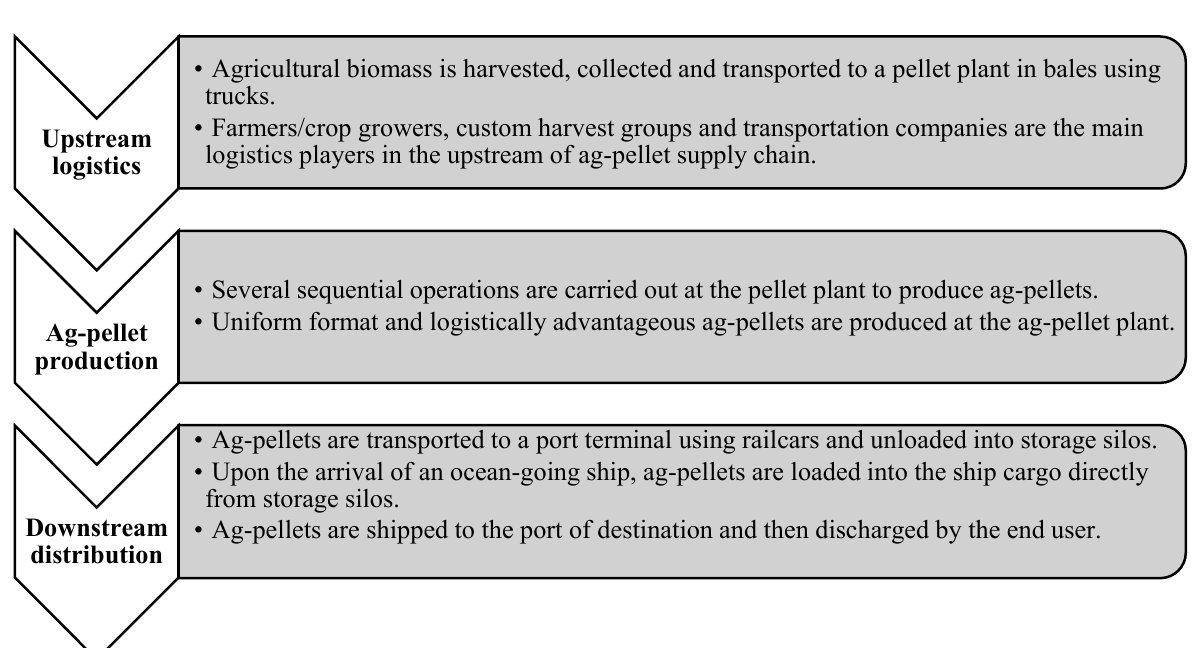
Figure 1. Different segments of the ag-pellet supply chain modeled and evaluated in this study.